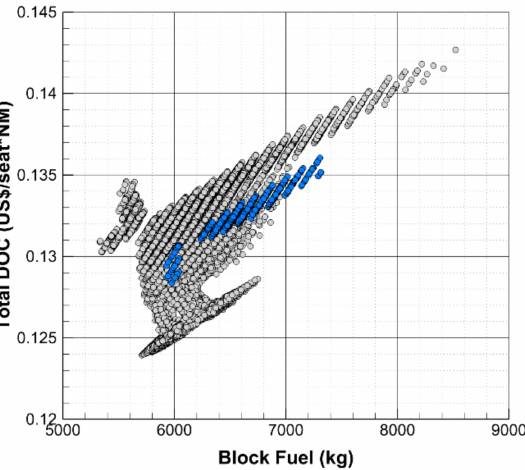
Figure 12. Total DOC versus block fuel for the three-lifting-surface rear-mounted engines configura- tion. Blue circles represent the solutions compliant with the imposed set of